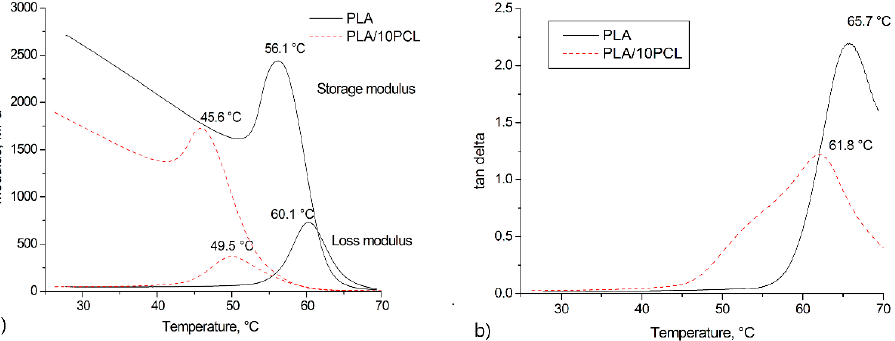
Figure 5. DMA curves of the dynamic elastic modulus, loss modulus ( a ) and tan δ ( b ) for PLA and PLA +